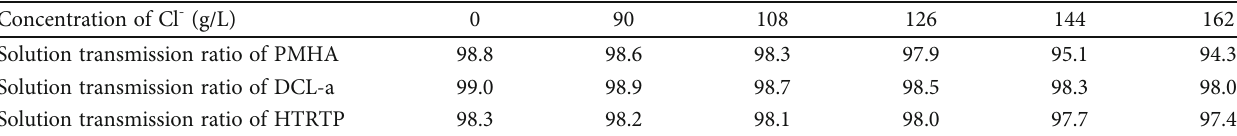
Table 3: Experimental results of antisalting out of PMHA.